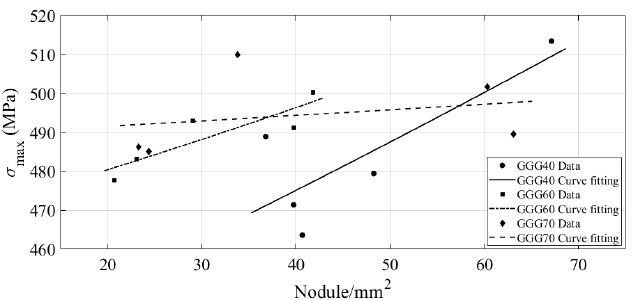
Figure 8. Relation between nodule density and maximum stress in GGG40, 60 and 70.